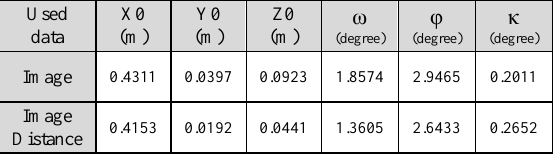
Figure 8. is flow chart of real system calibration. Real